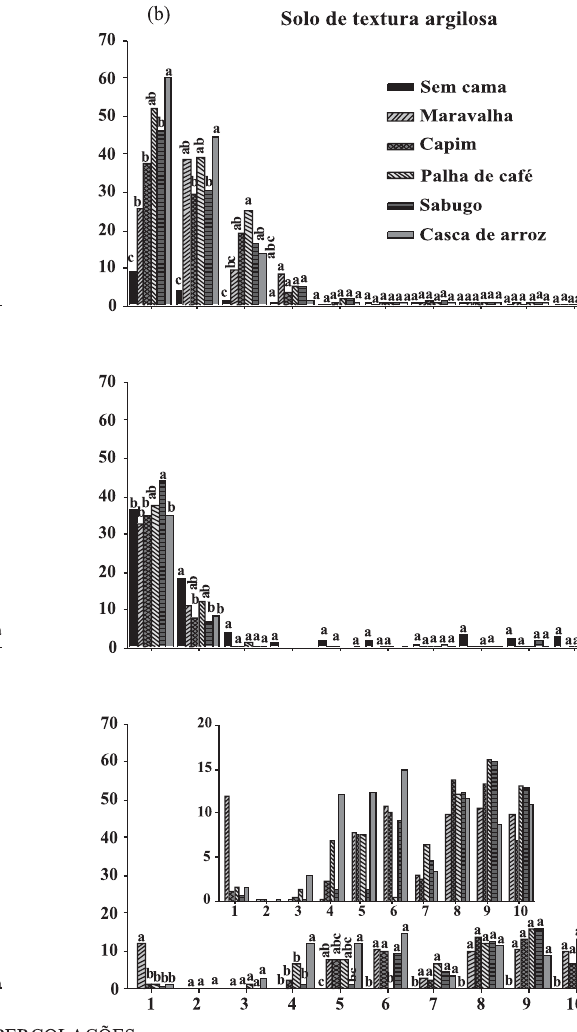
Figura 5. Concentrações dos ânions cloreto, nitrato e sulfato e de ácidos orgânicos de baixa massa molecular em percolados coletados sucessivamente, ao longo do tempo, em Latossolos de textura média e argilosa, que receberam 160 t ha -1 , base material seco, de cinco tipos diferentes de cama de aviário, no anel superior de colunas de percolação, comparados à testemunha, sem cama de aviário. As médias das concentrações dos elementos seguidas pela mesma letra em uma mesma percolação, para as diferentes camas, não diferiram entre si pelo teste de Tukey, a 5